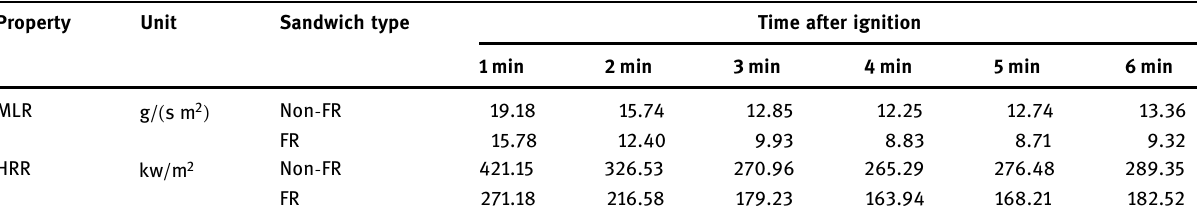
Table 3: Cone calorimeter test data for the FR and non - FR honeycomb sandwich panels